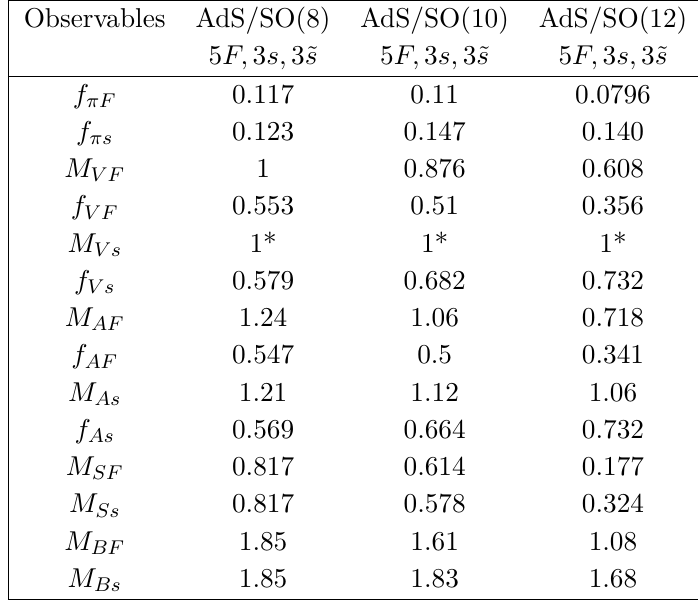
Table 10. Results for the gauge theories with matter in three